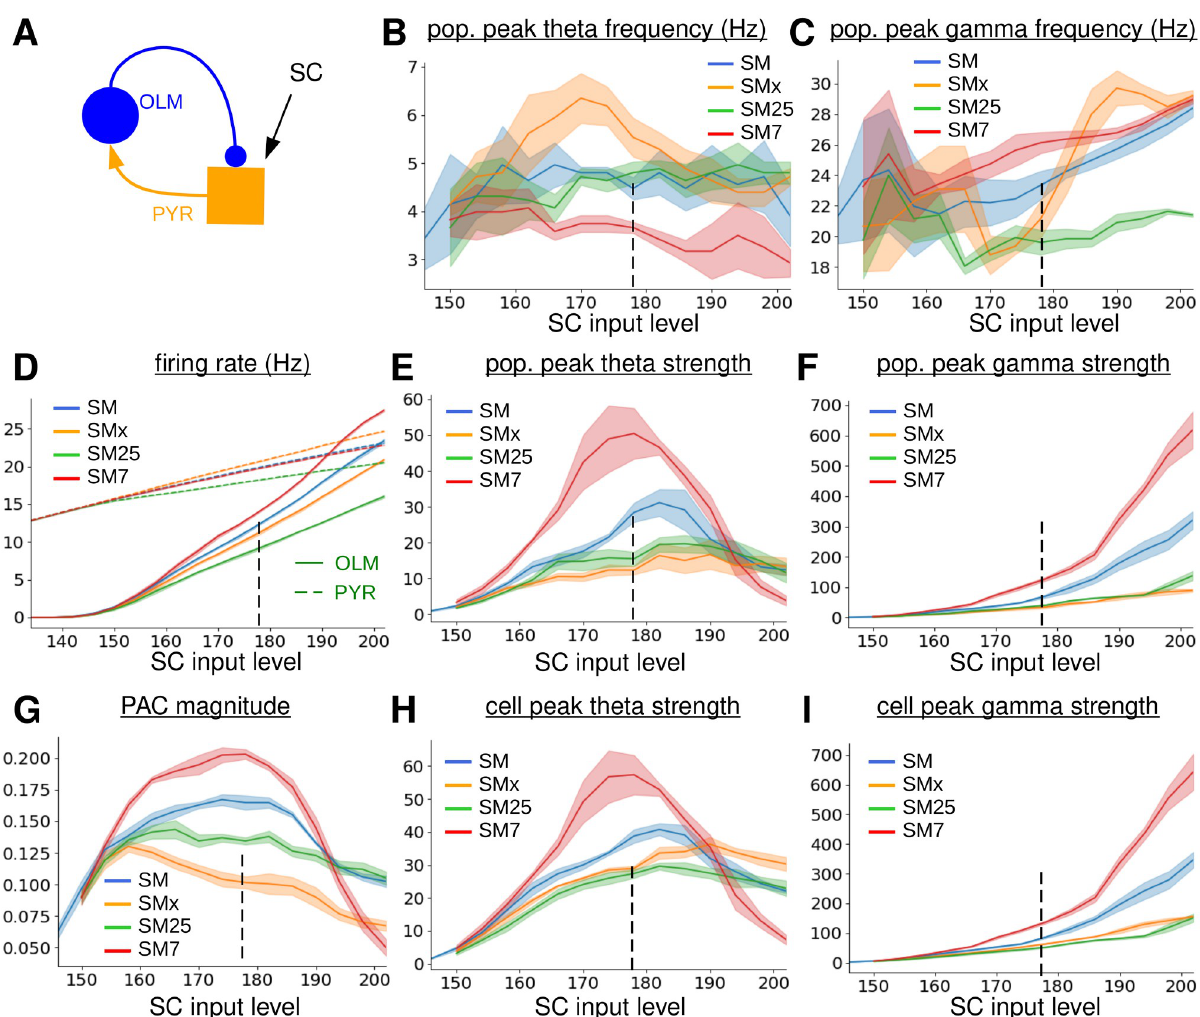
Fig 5. Dependence of TSGPAC on SCIL in the 120 PYR, 10 OLM simplified feedback circuit model with normal strength OLM-PYR synapses, denoted ‘SM’ (blue), no OLM-PYR connections, denoted ‘SMx’, (orange), strong OLM-PYR synapses and 25 ms GABA decay timescale, denoted ‘SM25’, (red) and strong OLM-PYR synapses and 7 ms GABA decay timescale, denoted ‘SM7’, (green). (A) Schematic of the simplified circuit model . (B) OLM population peak theta frequency. Location of power spectrum peak in 1-8 Hz band . (C) OLM population peak gamma frequency. Location of power spectrum peak in 15-50 Hz band . (D) OLM (solid) and PYR (dashed) firing rates . (E) OLM population theta strength. Theta band power spectrum peak size . (F) OLM population gamma strength. Gamma band power spectrum peak size . (G) OLM population total PAC magnitude in the theta, 1-12 Hz, band and slow-gamma, 12-50 Hz, band . (H) OLM single cell theta strength averaged across cells. Theta band power spectrum peak size . (I) OLM single cell slow gamma strength averaged across cells. Slow gamma band power spectrum peak size . (B-I) Shaded bands show SEM in the plotted values across two simulations with random configurations. Dashed vertical line indicates the simulation described in Fig